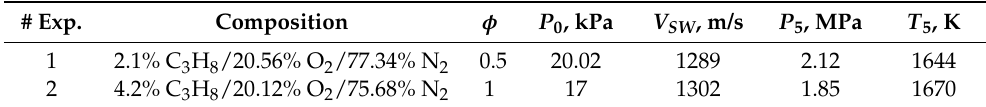
Table 1. Experimental